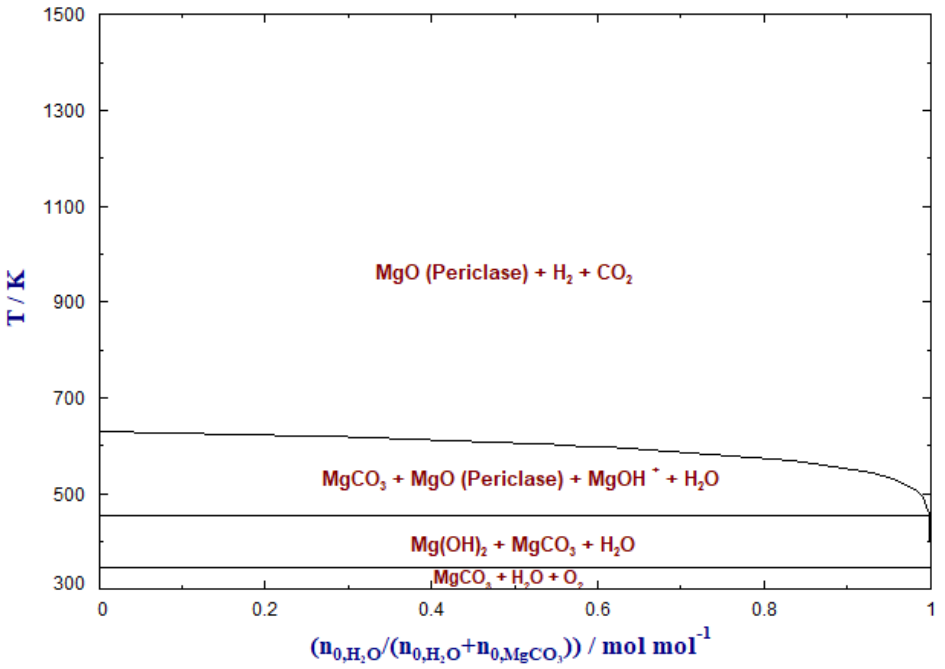
Figure 6. Equilibrium solid phase diagram of the system MgCO 3 –H 2 O: solid phase fields were predicted as a function of the temperature and the feed hydrogen mole fraction; gaseous products are not shown; data calculated with FactSage 8.0™ (Thermfact and GTT-Technologies). The solid phases at equilibrium were predicted as a function of the temperature and the feed H 2 O ( n 0,H /( n 0,H + n 0,MgCO )), where n 0 denotes the number of moles of the feed component.